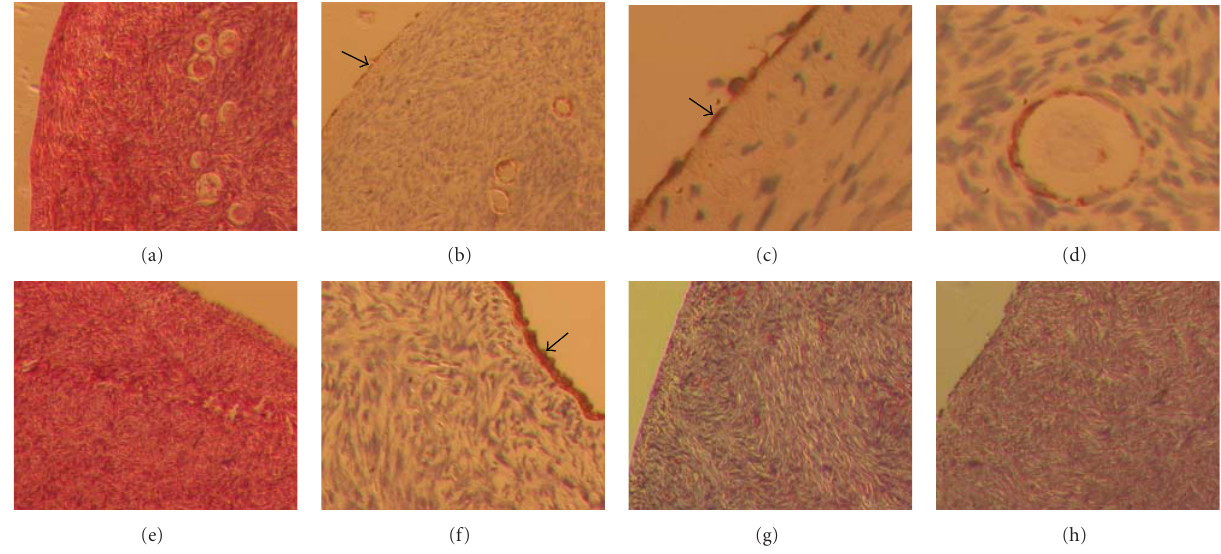
Figure 1: Histology of ovarian cortex sections in patients. (a) Ovarian cortex with primordial follicles after haematoxylin-eosin staining in the first patient (magnification 100-times). (b–d) Ovarian surface epithelium (arrow) and primordial follicles positively (brown) stained on cytokeratin in the first patient (magnifications 100-times and 200-times). (e, f) Fibrous ovarian cortex without follicles after haematoxylin- eosin staining and ovarian surface epithelium (arrow) positively (brown) stained on cytokeratin in the second patient (magnification 100- times). (g, h) Fibrous ovarian cortex without follicles after haematoxylin-eosin staining in the third patient (magnification 100-times). (Light microscope.)